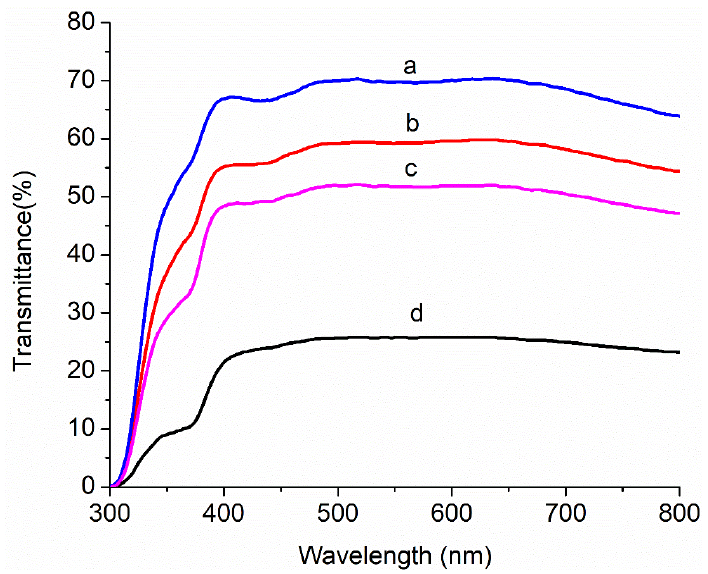
Figure 6. Transmittance spectra of Au (0.0, 0.5, 1.0 and 1.5 wt %)-doped ZnO–Sm nanoparticle films.